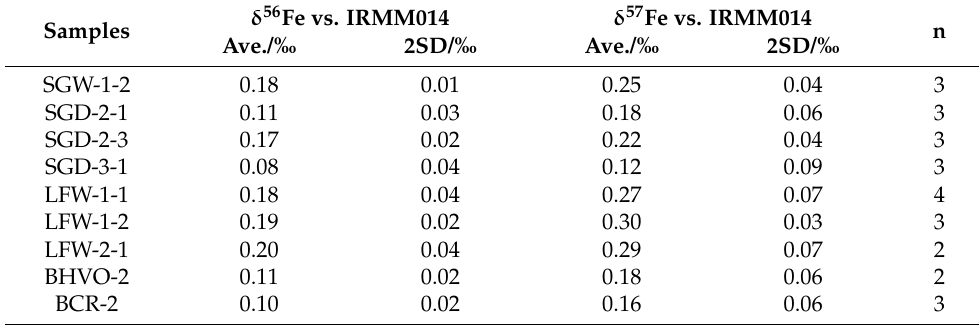
Table 3. Iron isotope compositions of representative samples.